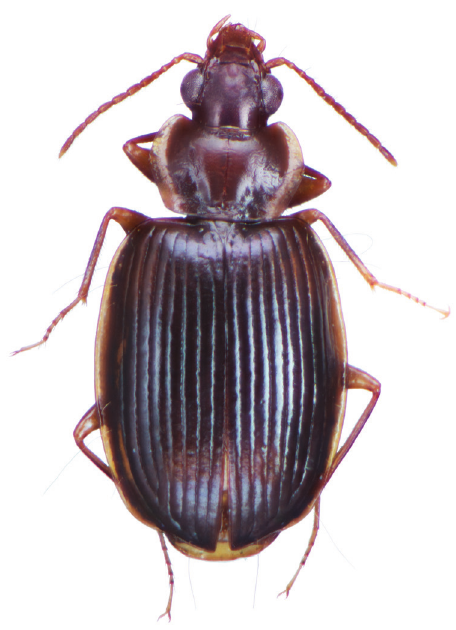
Figure 61. Dorsal habitus and color pattern of Dolichoctis badiadorsis sp. n.. (OBL 5.22 mm).